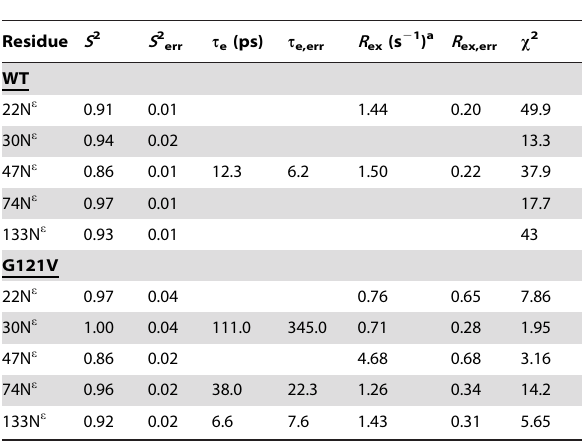
a R ex values are based on model-free fits. doi:10.1371/journal.pone.0033252.t001 PLoS ONE |